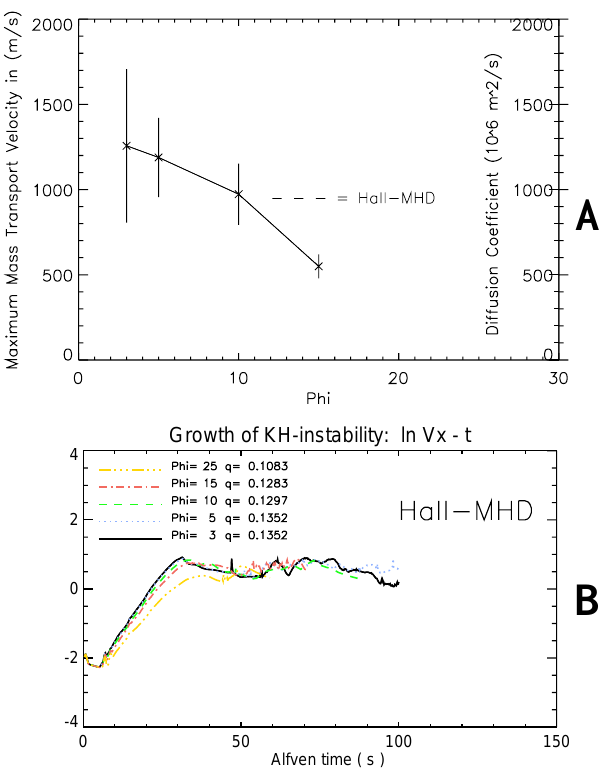
Fig. 9. (A) Mass transport velocity as a function of ϕ for short wave- length ( ka = 0 . 25, λ = 0 . 4 R E ) Hall-MHD. (B) Growth rates of KH instability for ϕ = 3 ◦ , 5 ◦ , 10 ◦ , 15 ◦ for Hall-MHD approximation.